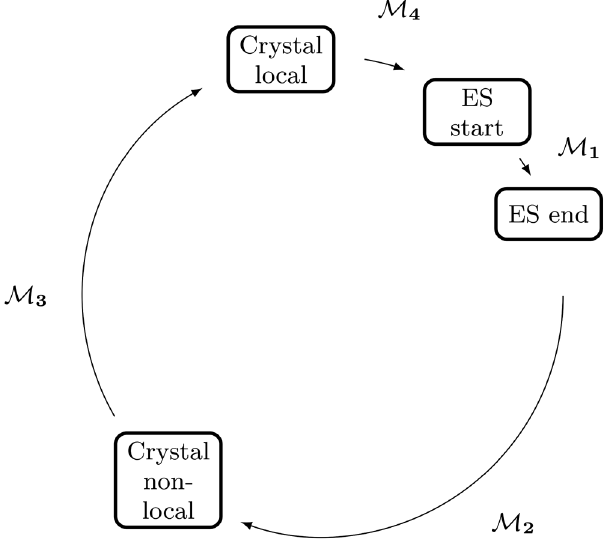
FIG. 8. Schematic view of the SPS maps chosen for tracking. For each sector, a symplectic map at the 4th-order is produced using MAD-X